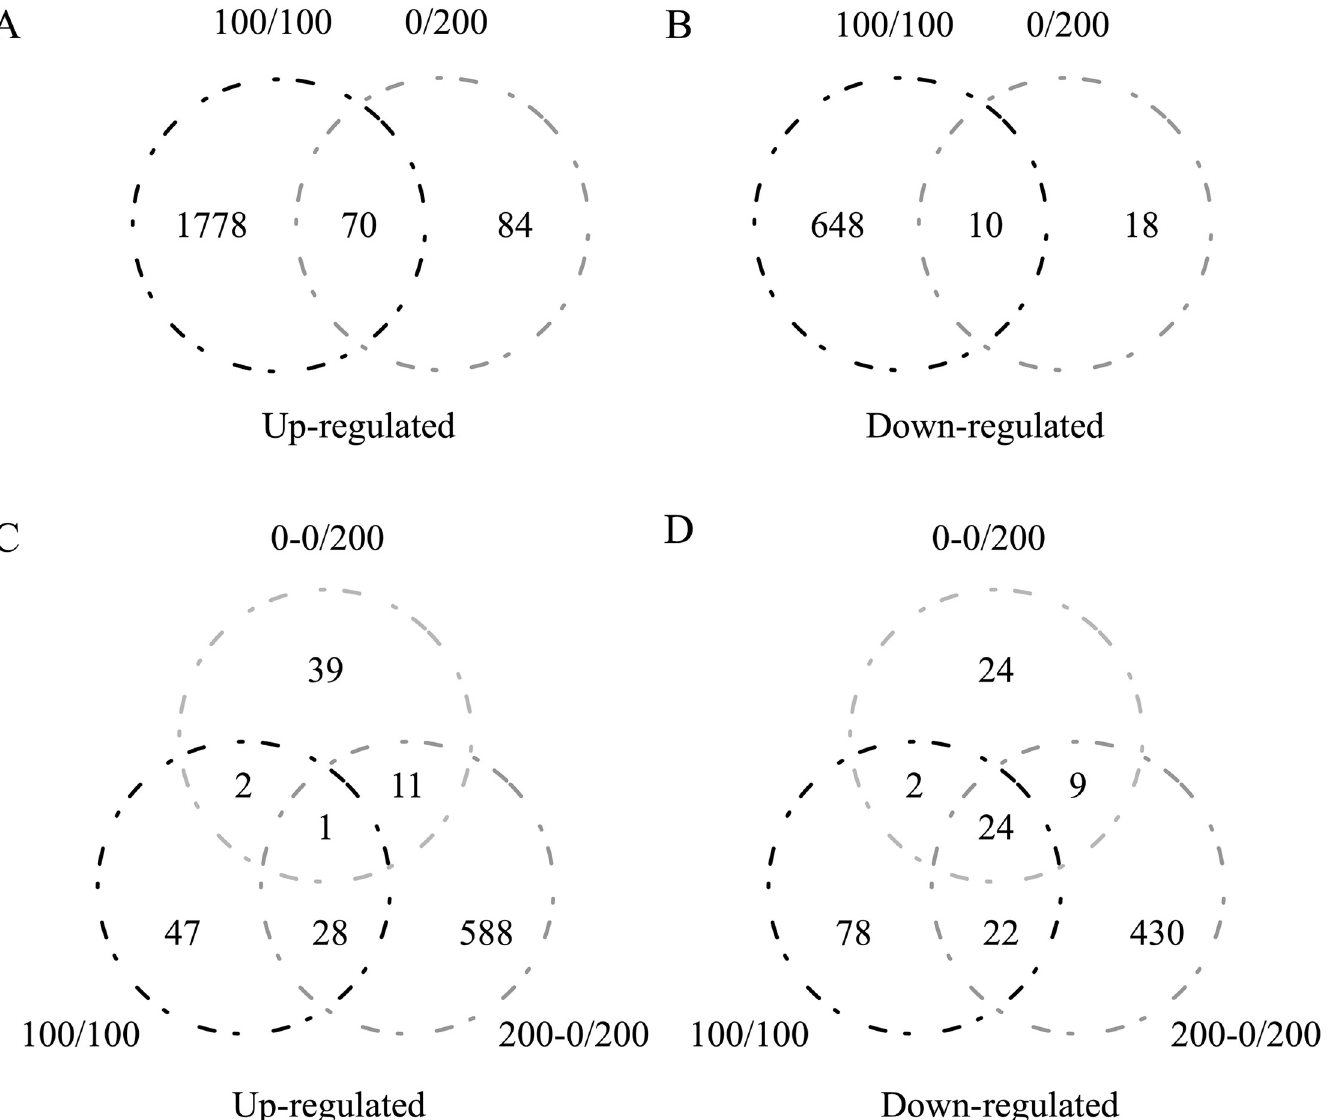
Fig 2. Venn diagram of DEGs whose expression was upregulated ( A ) or downregulated ( B ) in the leaves and upregulated ( C ) and downregulated ( D ) in the roots in the uniform (100 mmol � L -1 NaCl) and nonuniform (0 mmol � L -1 and 200 mmol � L -1 NaCl) salinity treatments, as revealed by